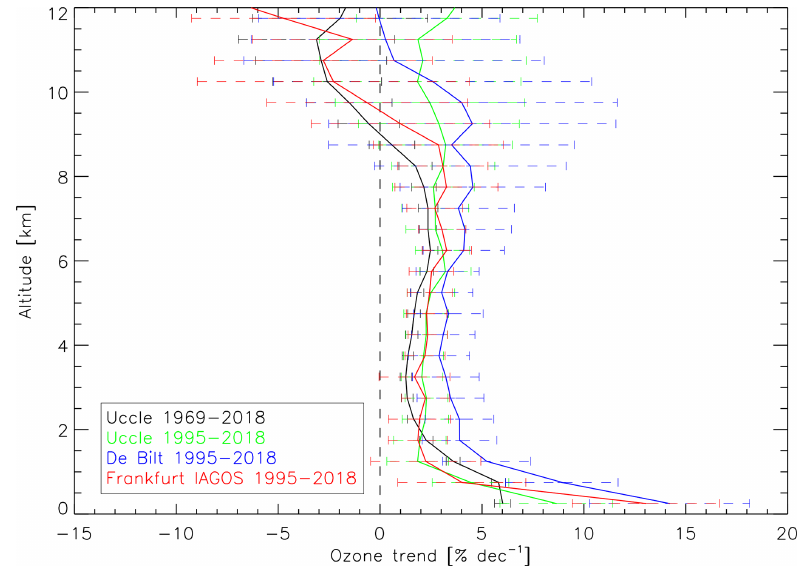
Figure 3. Vertical distribution of trends in tropospheric ozone concentrations at Uccle for different periods, and at De Bilt (ozonesonde data) and Frankfurt (IAGOS data) for 1995–2018. Simple linear trends are calculated for monthly ozone anomalies in 1km altitude ranges, and the error bars are 2 σ standard deviations. The same colour coding is used as in Fig. 2: trends for the most recent Uccle sub-period (here 1995–2018) are in green; for the entire Uccle time series trends, we use black; and the De Bilt trends are shown in blue. The red line denotes the Frankfurt IAGOS trends in this